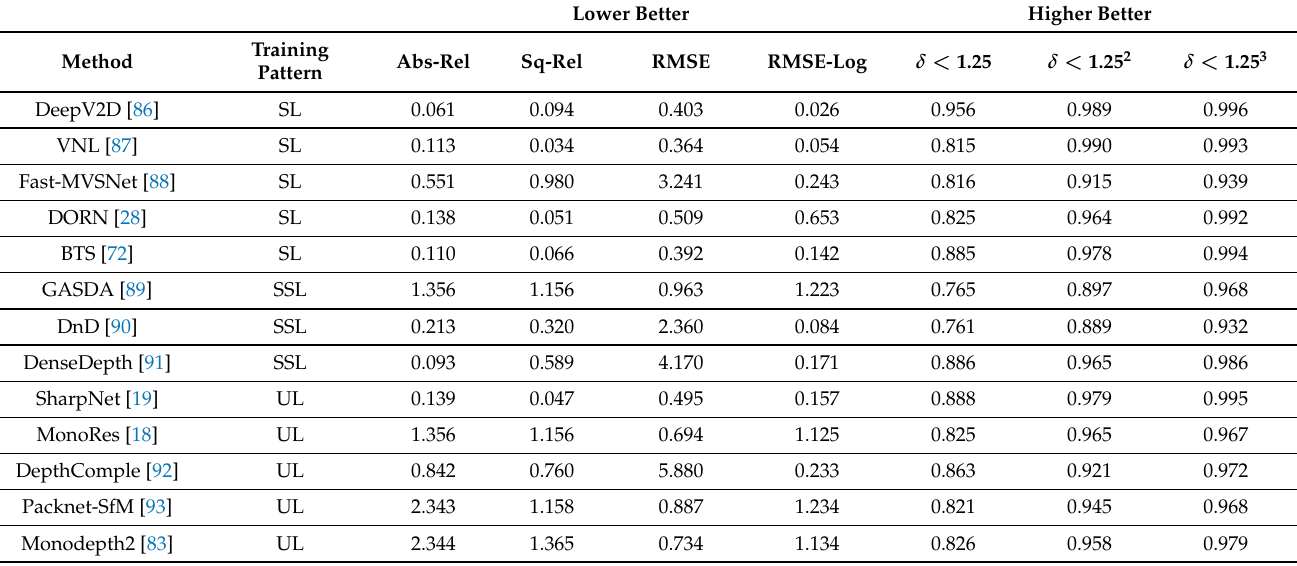
Table 3. Comprehensive information about the quantitative results of the DL algorithms investigated on the NYU-V2 dataset. Lower Better Higher